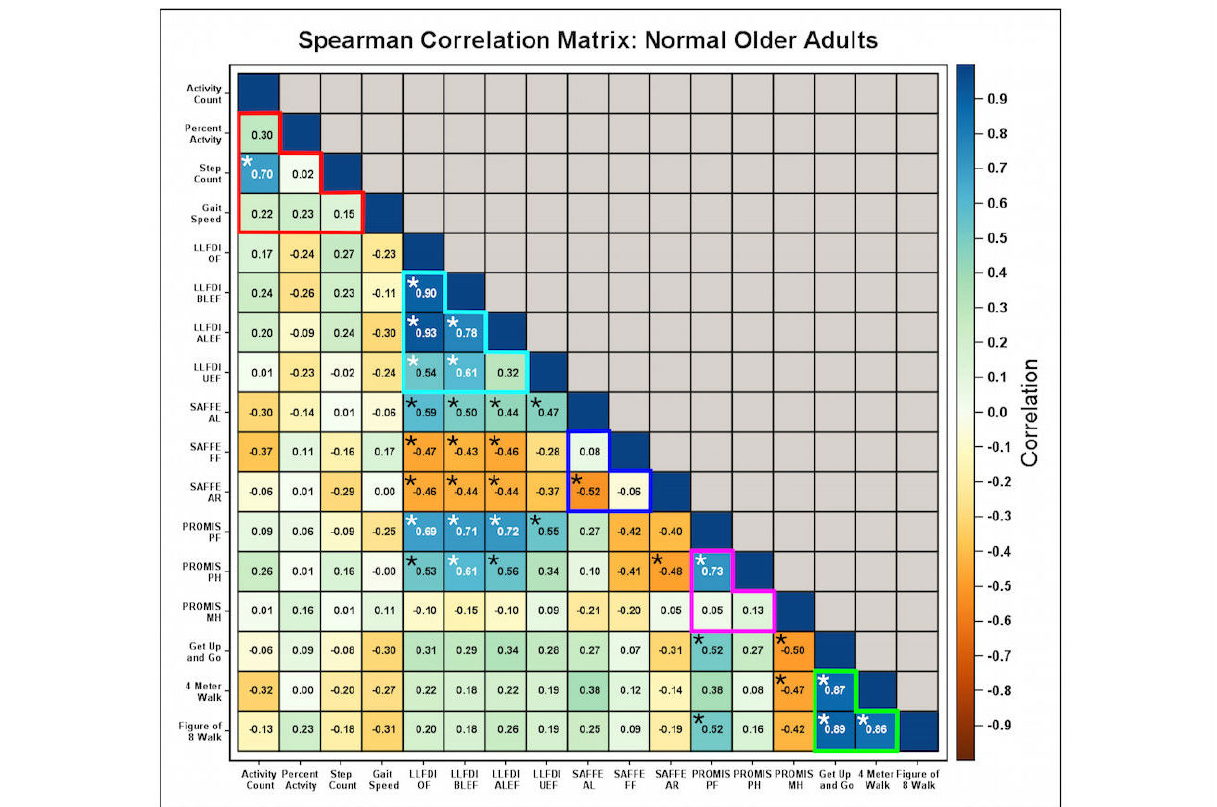
Figure 6. Multiple significant correlations across different functional assessment metrics are present in functionally intact older adults. Confusion matrix depicting correlation structure (metrics across matrix bottom row) of mobile phone-based activity measures (activity count, percent activity, step count, gait speed), questionnaire-based measures of functional status (LLFDI, SAFFE, PROMIS), and performance battery based measures of functional status (Get Up and Go, 4 meter walk, F8W) for functionally intact participants. For each entry, correlation strength is depicted as the color within the box; interpretation color bar provided on the right. Numeric values within each box are individual correlations. Asterisks depict interactions with P values less than .01. Interactions grouped within the red lines depict correlations within mobile phone-derived activity measures; interactions grouped within cyan lines depict correlations within LLFDI measures; interactions grouped within blue lines depict correlations within SAFFE measures; interactions within grouped violet lines depict correlations within PROMIS measures; interactions grouped within green lines depict correlations within performance battery